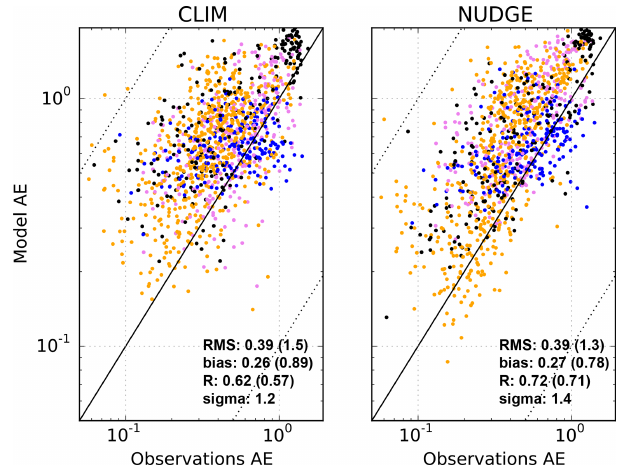
Figure 20. As Fig. 19 for the Ångstrom exponent.